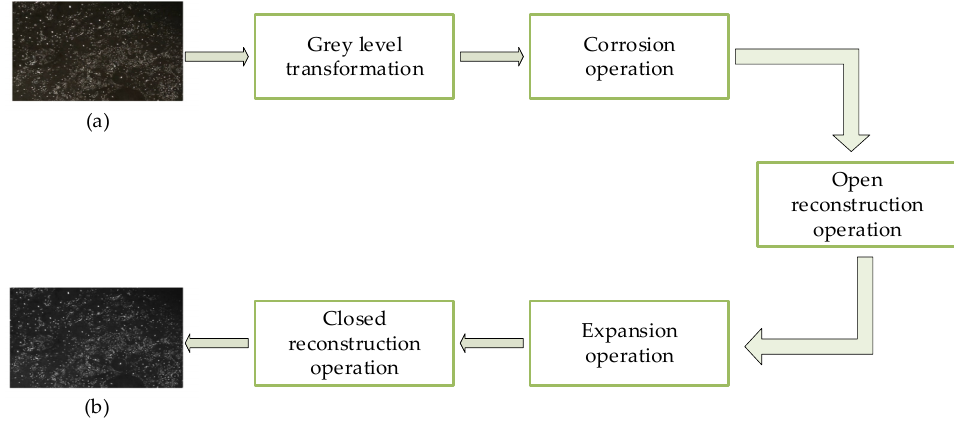
Figure 5. Flow chart of froth image preprocessing.